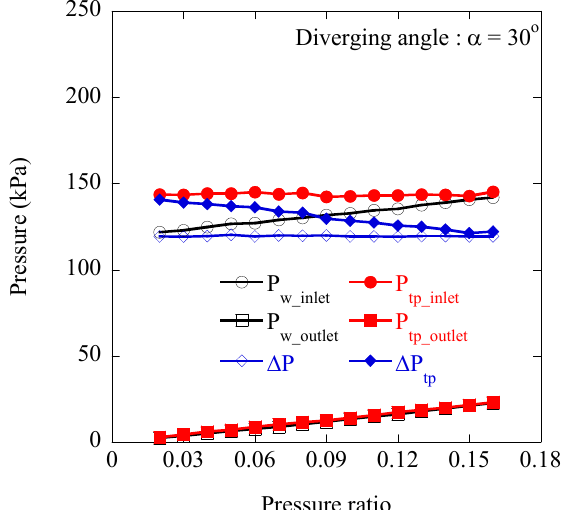
Figure 8. In the case of the diverging angle of 30 ◦ , pressure variation for a water single phase and a water–air two-phase according to the pressure ratio.